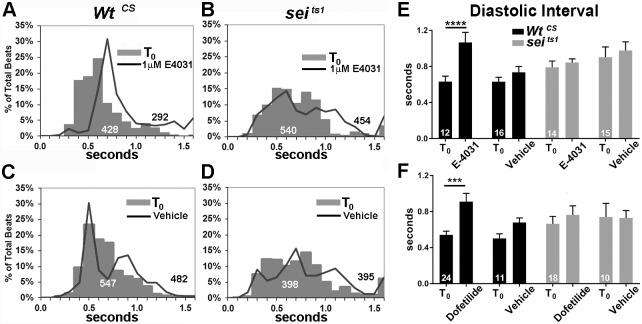
hERG antagonists E-4031 and Dofetilide cause bradycardia.(A) Histogram of binned diastolic intervals from 12 WtCS hearts before and after exposure to 1μM E-4031 expressed as a percentage of total DIs (totals are show in white for T0 and black for records at 15 min after drug / vehicle exposure). (B) Distribution of DIs in hearts from 14 sei/hERG mutants before and 15 min after exposure to 1μM E-4031. (C) Distribution of DIs in hearts from16 WtCS before and 15 min after exposure to AHL vehicle. (D) Distribution of DIs in hearts from 15 sei/hERG mutants before and 15 min after exposure to AHL vehicle. (E) Average DIs before and after exposure to either 1μM E-4031 or vehicle. (F) Average DIs before and after exposure to either 1μM Dofetilide or DMSO vehicle. Plotted values are mean ± SEM; significance was determined using a two way ANOVA and Sidak’s multiple comparisons test; *** p<0.001; ****p<0.0001.